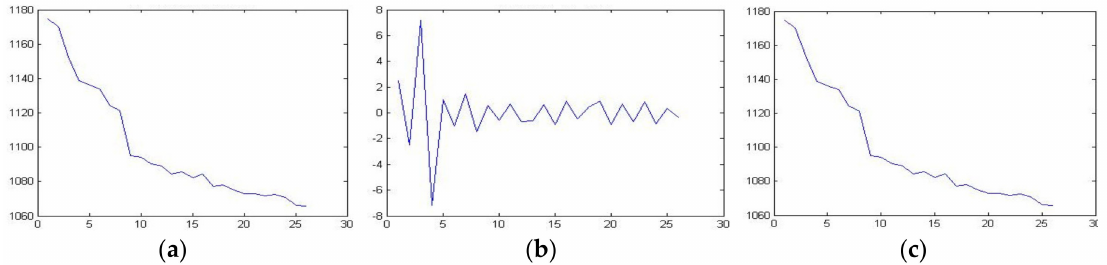
Figure 7. ( a ) Temperature and resistance curve with random noise; ( b ) Details of wavelet transform; ( c ) Approximate part of wavelet transform. Here, the abscissa represents the temperature value ( ◦ C), and the ordinate represents the corresponding resistance value (ohm).